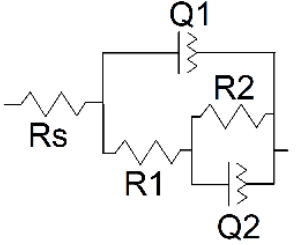
Figure 12. Equivalent circuit for the assessment of EIS parameters.